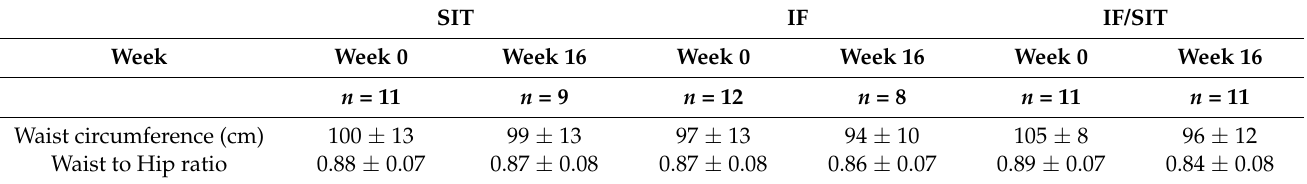
Table 2. The effect of diet and/or exercise intervention on waist circumference and waist to hip ratio.